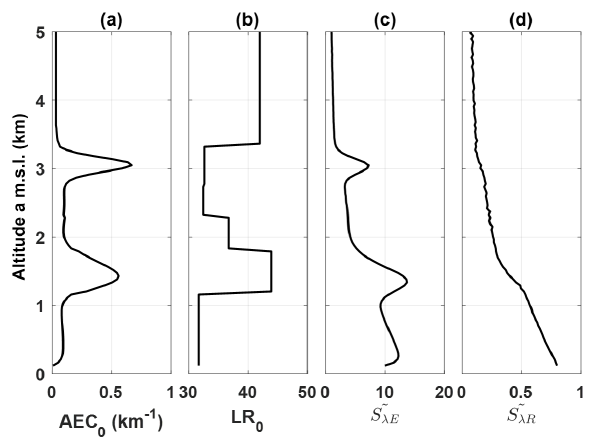
Figure 7. Input profiles of (a) aerosol extinction coefficient (AEC 0 ) and (b) lidar ratio (LR 0 ) for the statistical error study. One draw of the 100 simulated profiles of range-corrected (c) elastic signal and (d) Raman signal is